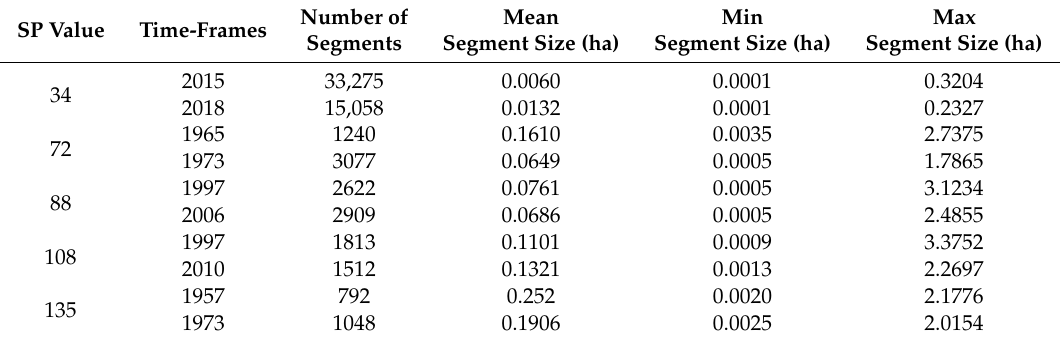
Table A1. The relationships between the SP candidates and the resulting segmented image object size and count—the example of repeating SP candidates in at least two time-frames.